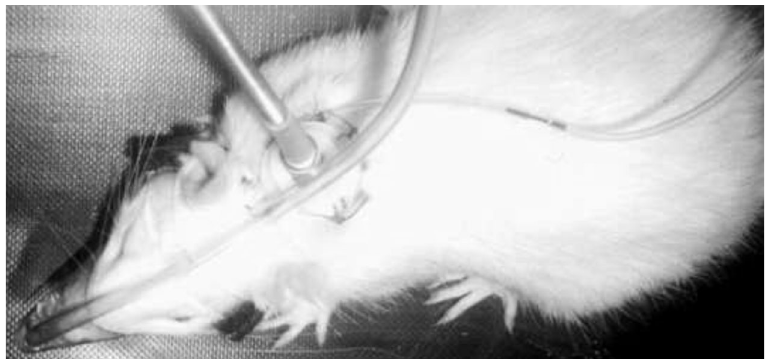
Figure 1. Rat connected to a metabolic mask and flow probe for oxygen consumption and cardiac output